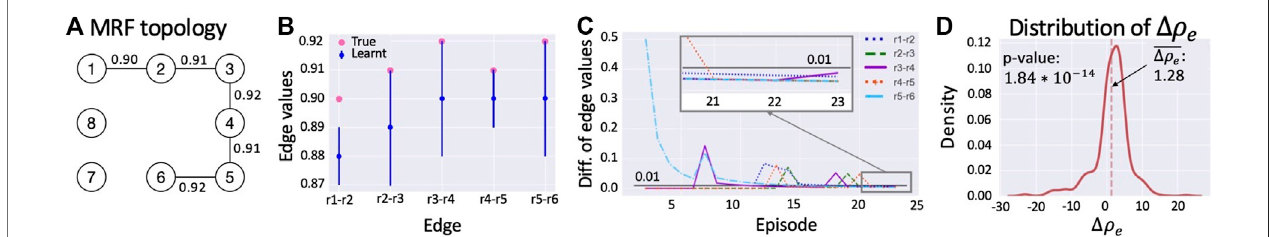
FIGURE 6 | (A) True MRF topology with the equality probability constraints on its edges. (B) True MRF and average of the learned MRFs. Pink dots represent the valuesontheedgesofthetrue MRF,whereas bluedotsandlines correspond totheaverageedgevaluesofthelearned MRFandtheirstandarddeviations, respectively. (C) Difference of edge probability values during execution of the learning process until the convergence is reached in episode 23. The black line represents the convergence threshold. (D) Density of difference in discounted return from